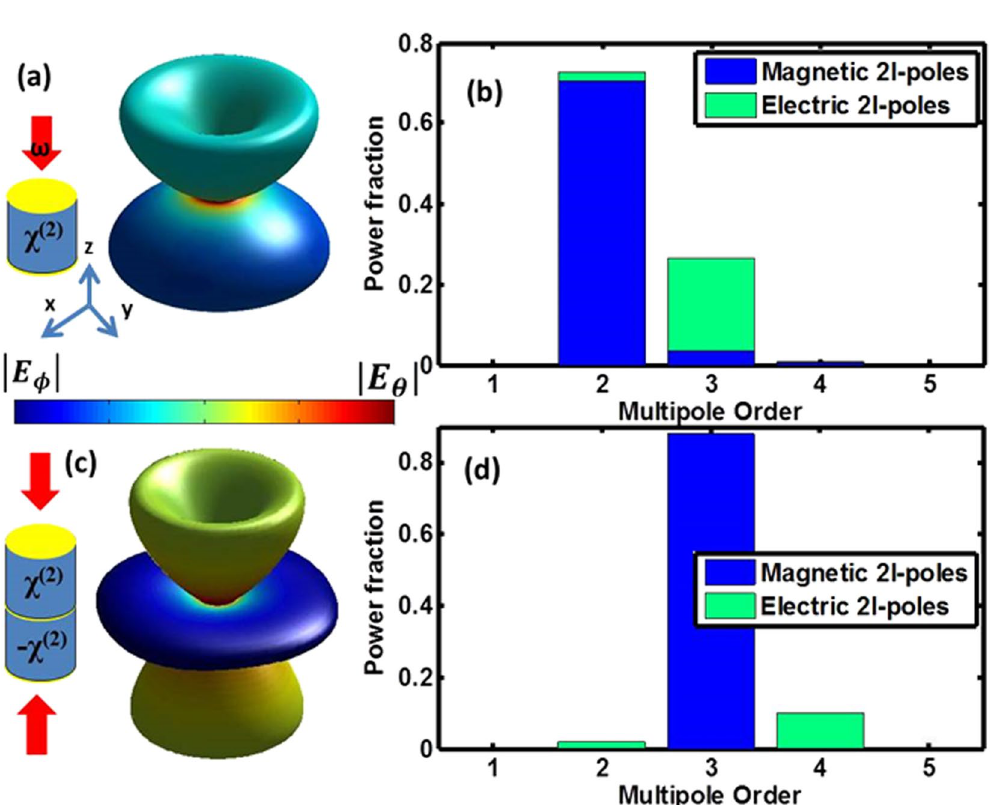
Figure 5. ( a ) Centro-symmetric resonator and the SH radiation pattern it produces. ( b ) Multipolar decomposition of the radiation pattern in ( a ). ( c ) Anti-centro-symmetric resonator and the SH radiation pattern it produces. ( c ) Multipolar decomposition of the radiation pattern in ( b ). ( d ) Multipolar decomposition of the radiation pattern in ( c ). Cylinder radius: 0.35 µ m, height: 0.4 µ m, Gold disk height: 20